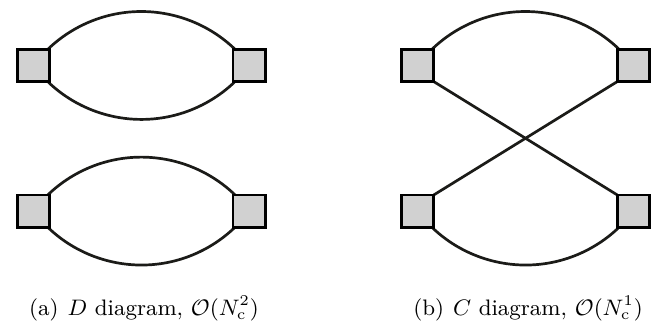
Figure 2 . Diagrammatic representation of the quark Wick contractions contributing to the SS and AA channels. Grey squares represent a pion operator and solid lines are quark